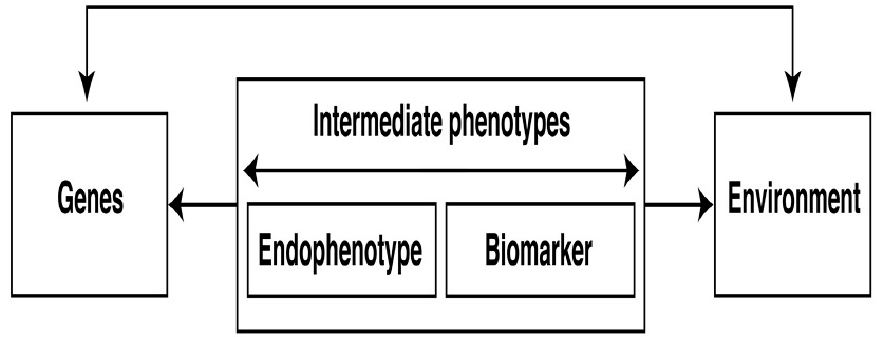
Figure 2. Endophenotypes and biomarkers should be considered subsets of intermediate phenotypes